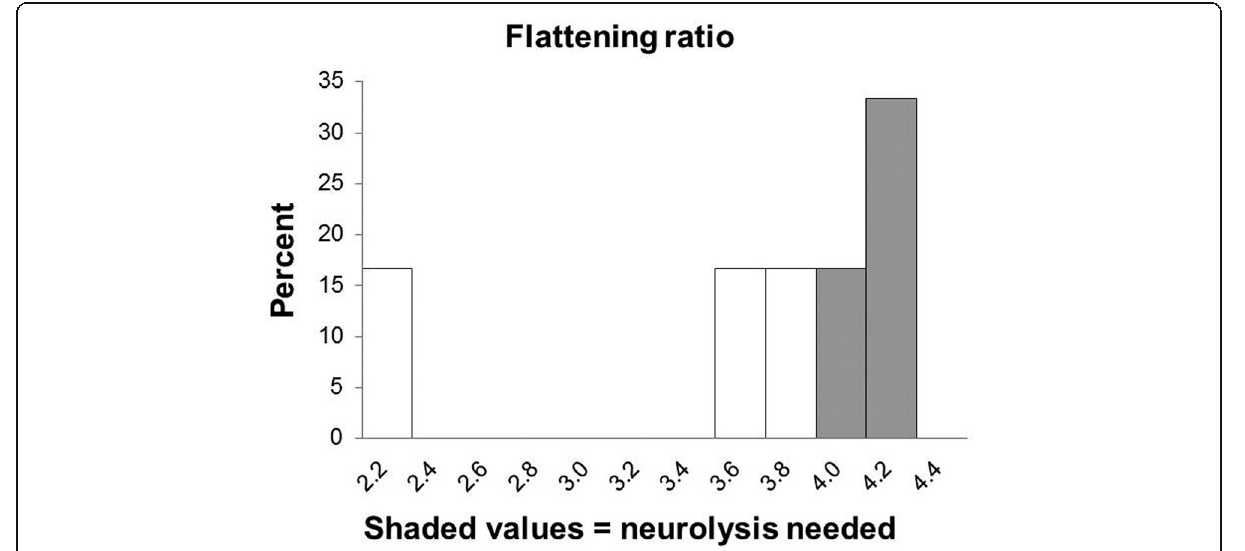
Fig. 3 Histogram of the flattening ratio and need for neurolysis